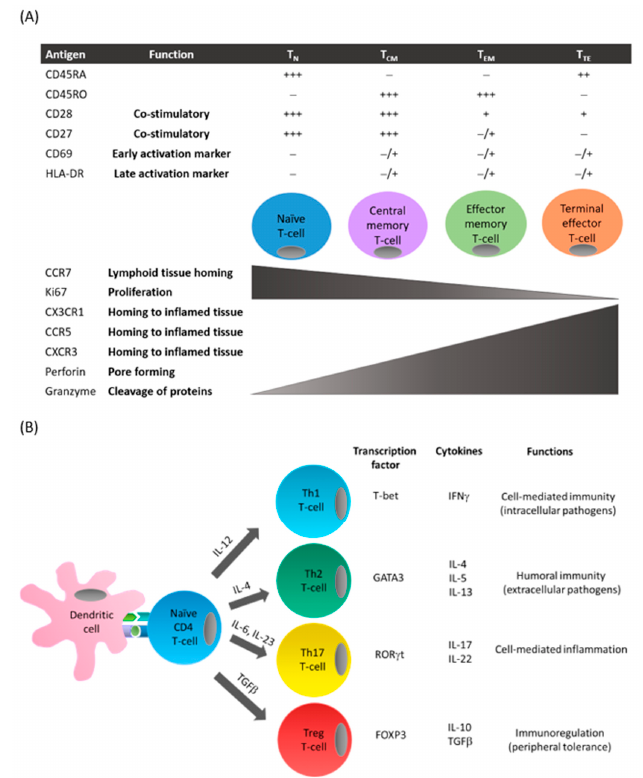
Figure 1. T-cell di ff erentiation. ( A ) Following antigen presentation by antigen-presenting cells such as dendritic cells, naïve T-cells can di ff erentiate to central memory or e ff ector T-cells. This process is associated with the presence ( + ) or absence ( − ) of cell surface receptor expression on T-cells including costimulatorymoleculesandchemokinereceptors, andfunctionsincludingproliferationandcytotoxicity. ( B ) Depending on the costimulatory signals and the cytokines produced by antigen-presenting cells in the surrounding microenvironment, CD4 + T-cells express specific transcription factors that favor the di ff erentiation into the di ff erent T-cell subsets. These subsets can be characterized by their distinctive cytokine secretion profile and associated e ff ector